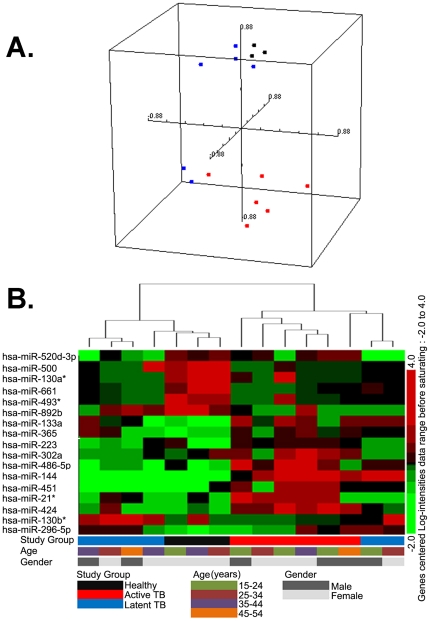
Multi-dimensional scaling of the relationships and unsupervised hierarchical clustering based on the 17 miRNAs expression pattern.A. Multi-dimensional scaling generated by BRB Arraytools of the relationships between the 15 samples based on the 17 miRNAs expression pattern. Red dot, active TB; Blue dot, latent TB; Black dot, healthy controls. B. The tree generated by unsupervised hierarchical clustering (Pearson's correlation, average linkage) of 15 samples (columns) and 17 miRNAs differentially expressed among the 3 groups predicted by using the SVM method. Sample clusters can be compared with the clinical parameters displayed in blocks underneath each profile. A key is provided at the bottom of the figure. Subjects' clinical status is indicated as follows: patients with active TB are indicated by red rectangles; subjects with LTBI by blue rectangles; and healthy controls by black rectangles. Age is indicated as: subjects between 15–24 years old are indicated by olive green rectangles; subjects 25–34 years old by brown rectangles; subjects 35–44 years old by purple rectangles; and subjects 45–54 years old by khaki rectangles. Females are indicated by hoar rectangles and males by darkish rectangles.